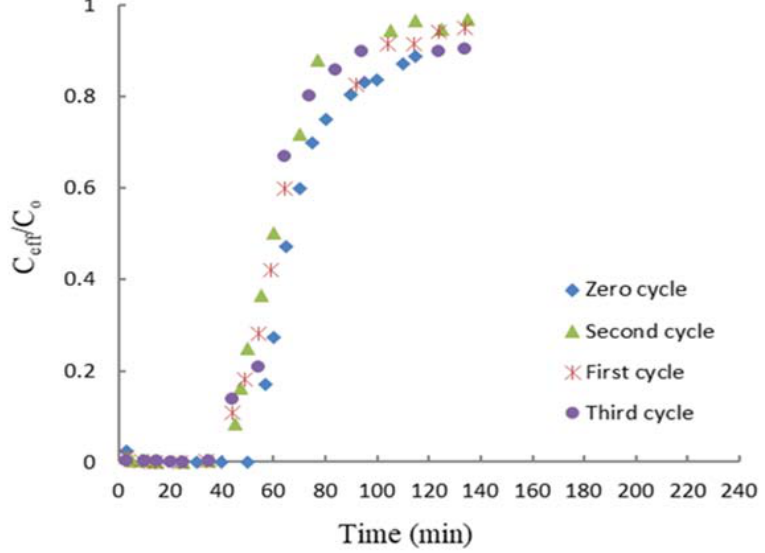
Figure 8. Curves of multiple breakthrough for phenol adsorption (1000 mg/L) at a constant 8 mL/min rate of flow & 8.5 cm bed depth.